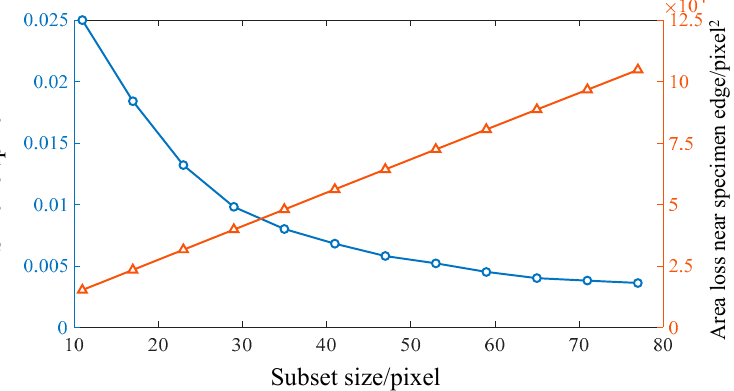
Figure 2. Standard deviation (SD) error of u-displacement and area loss near specimen edge vs. subset size.